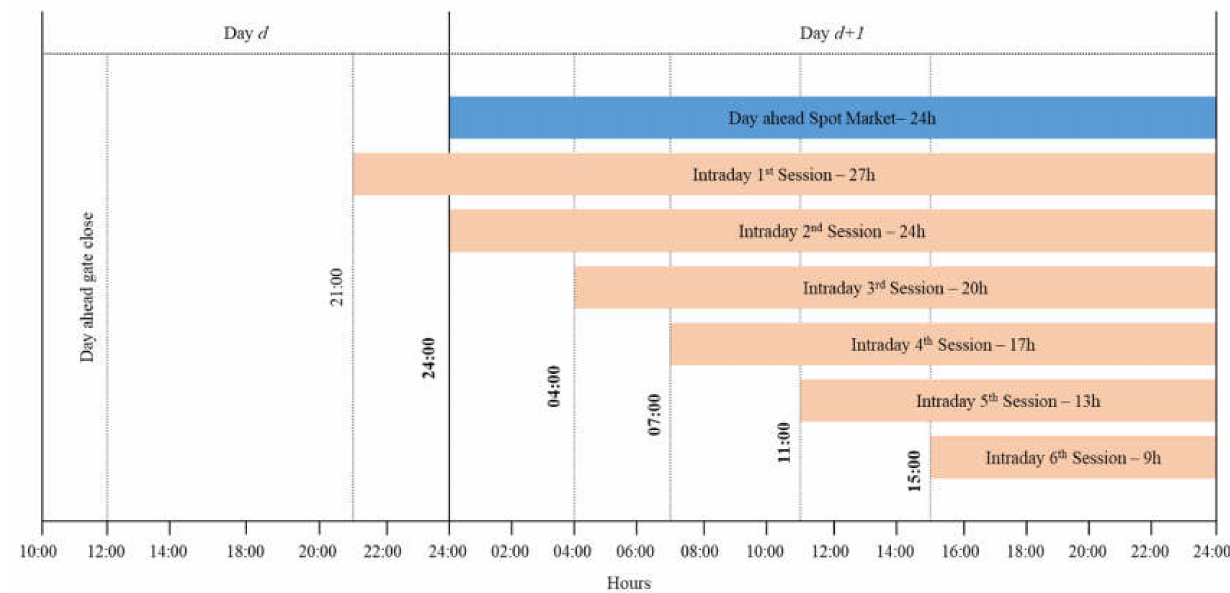
Figure 2. Negotiation options in the MIBEL